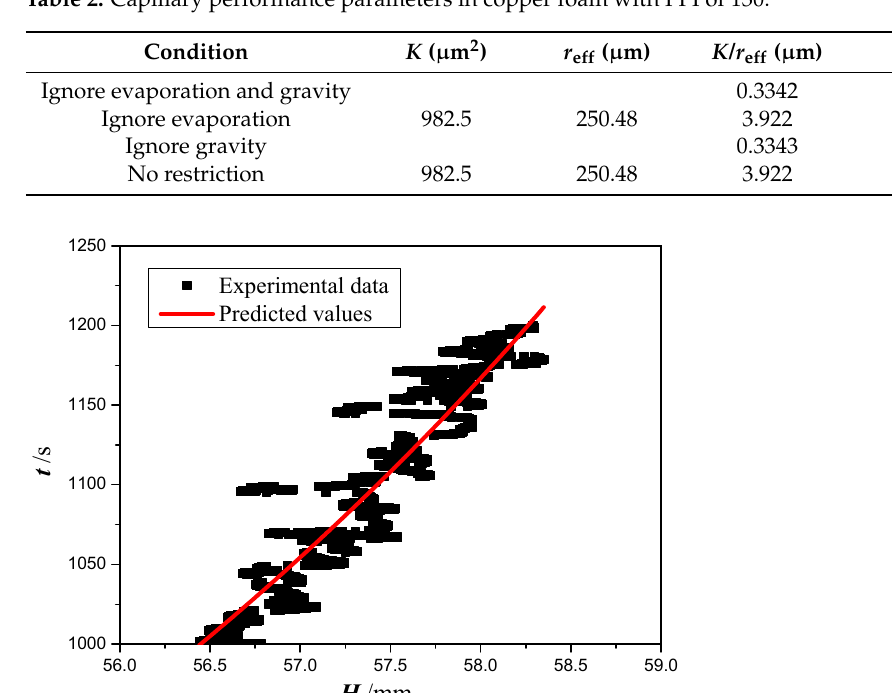
Figure 8. Wicking height versus time in copper foams with different PPI. Table 2. Capillary performance parameters in copper foam with PPI of 130. Table 2. Capillary performance parameters in copper foam with PPI of 130.